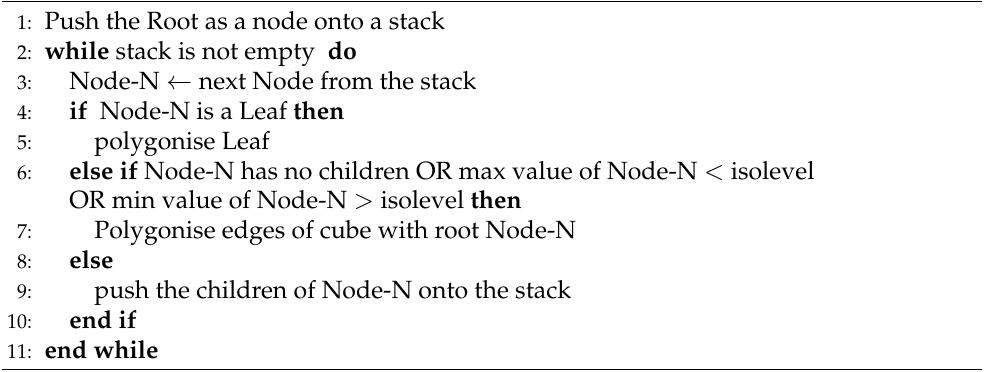
Algorithm 3 Embedding Marching Cubes into an octree